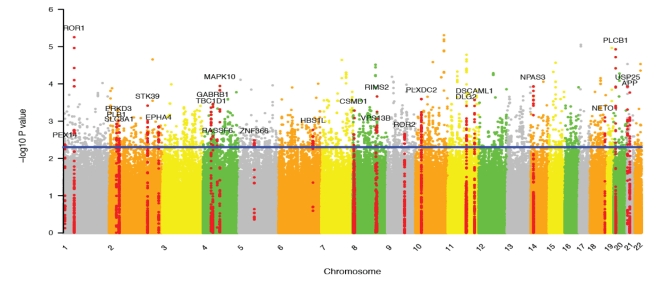
Manhattan plot for genetic association of insomnia.The name of the genes harboring more than 10 significant SNPs is shown at the corresponding chromosomal position. The SNPs residing in these genes are shown as red dots.